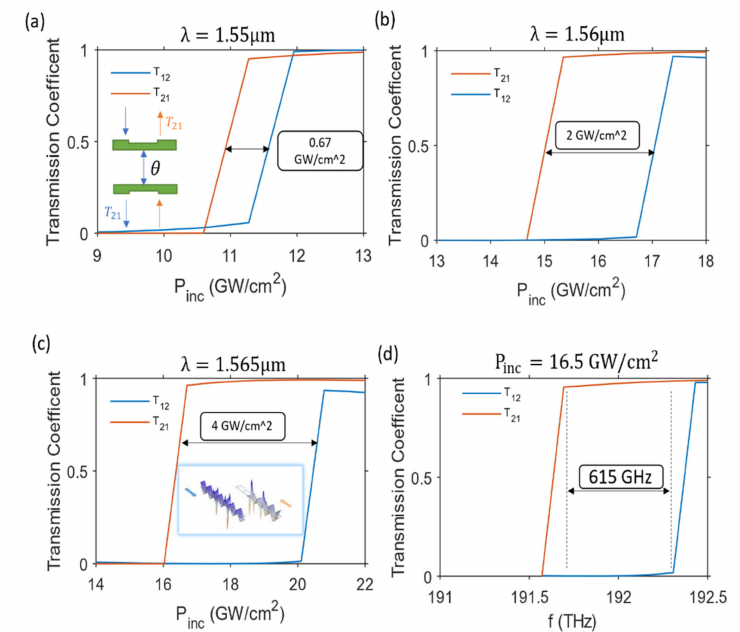
Figure 5. Full wave simulation results for transmission from opposite ports ( T 12 , T 21 ) of the pro- posed bilayer metasurface shown in the inset of ( a ), where the top resonator has dimensions ( d 1 = 0.203 λ , d 2 = d 1 /4 ) and the bottom resonator has dimensions ( d 1 = 0.18 λ , d 2 = d 1 /3 ) for the electrical distance θ = 1.5 π = 2 π / λ l , and l is the physical distance between the two res- onators. The period of the two-groove array is λ /2 where λ = 1.55 µ m. The transmission of a normally incident plane wave with increased input power P inc at ( a ) wavelength λ 0 = 1.55 µ m, ( b ) λ 0 = 1.56 µ m and ( c ) λ 0 = 1.565 µ m. The inset in ( c ) shows the full wave simulation of the magnetic field when the device is excited from each side separately when P inc = 18 GW/cm 2 . ( d ) Transmission from two sides versus the frequency at a fixed power level of 16.5 GW/cm 2 . The NRIR and transmission for the plots from ( a ) to ( c ) are NRIR = [0.27, 0.541, 0.984] dB, and the peak transmission is T = [ − 0.132, − 0.04, − 0.037] dB,